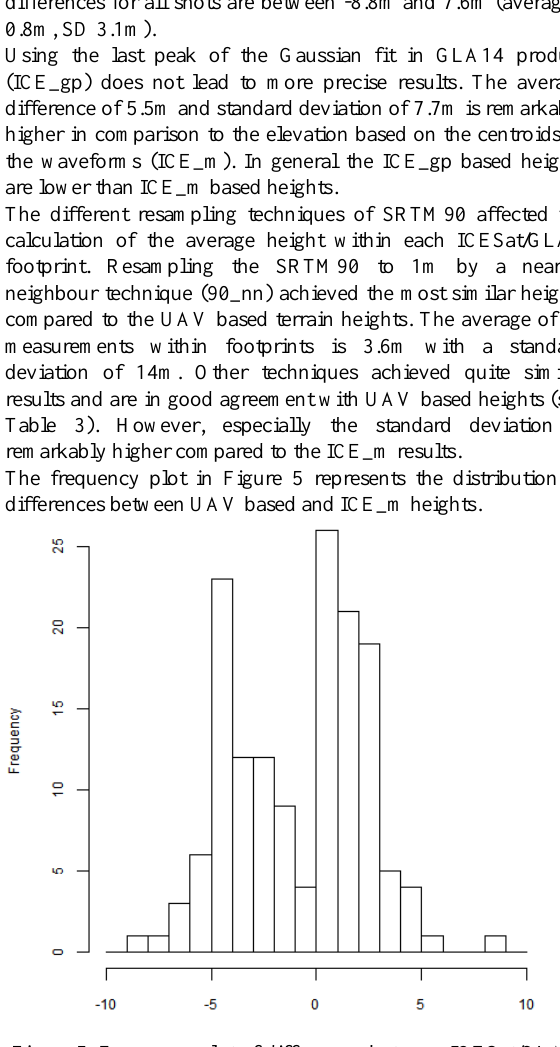
Figure 5. Frequency plot of differences between ICESat/GLAS heights and UAV based heights. Width of each bar is 1m.